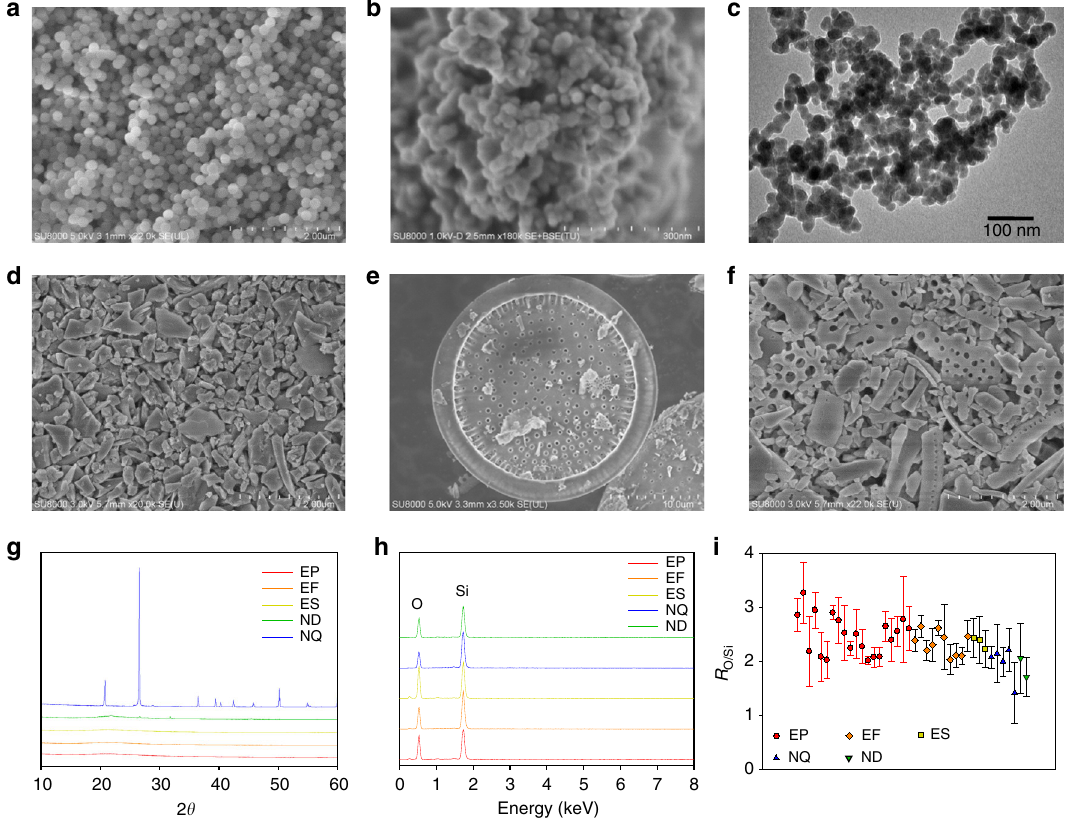
Fig. 1 Characterization of SiO 2 NPs of different origins. a Typical SEM image of a SiO 2 NP standard. b , c Typical SEM ( b ) and TEM ( c ) images of engineered SiO 2 NPs. d SEM image of natural quartz particles. e , f SEM images of intact ( e ) and fragmentary ( f ) diatomite particles. g , XRD patterns of engineered and natural SiO 2 NPs. h EDX patterns of engineered and natural SiO 2 NPs. i The atomic ratio of O to Si ( R O/Si ) of engineered and natural SiO 2 NPs based on the EDX measurements. The error bars represent 2s.d. ( n = 4-15). EP, EF, ES, ND, and NQ represent precipitated silica, fumed silica, sol – gel silica, diatomite, and quartz,